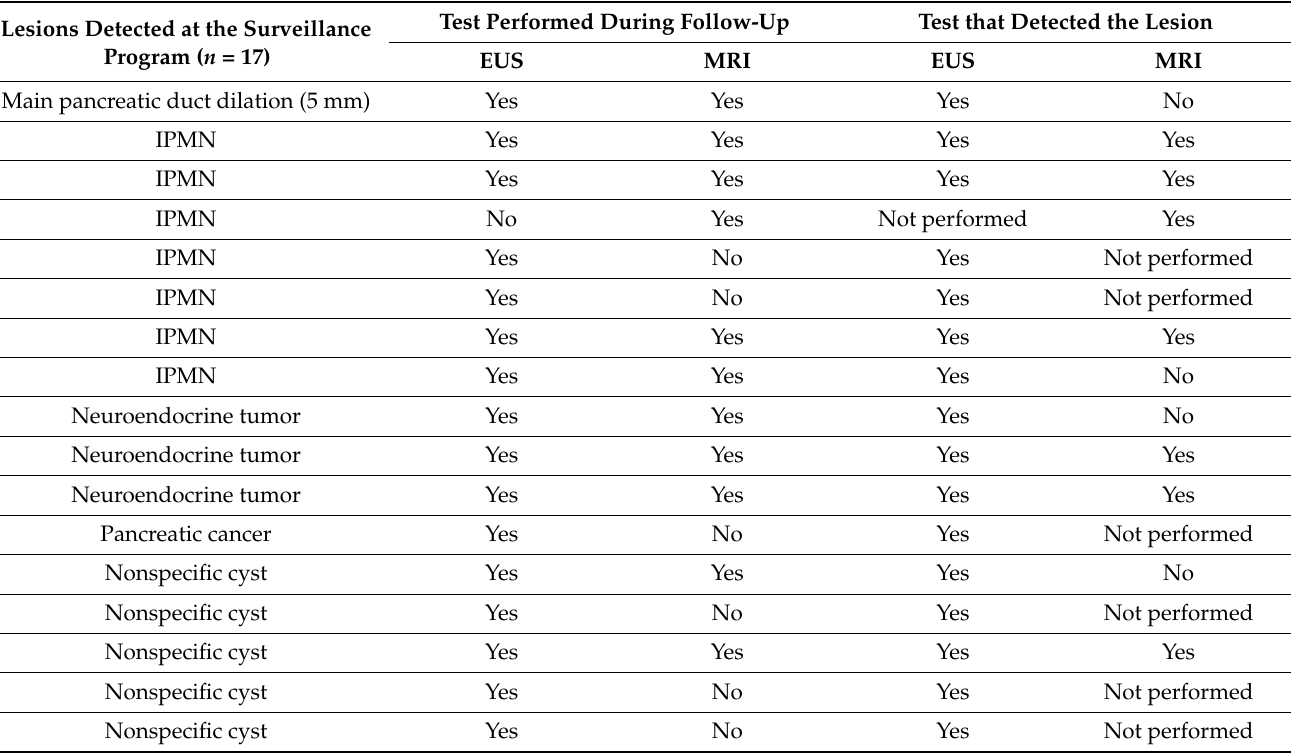
Table 2. Surveillance findings, n = 16 in 17 individuals. EUS, endoscopic ultrasound; MRI,